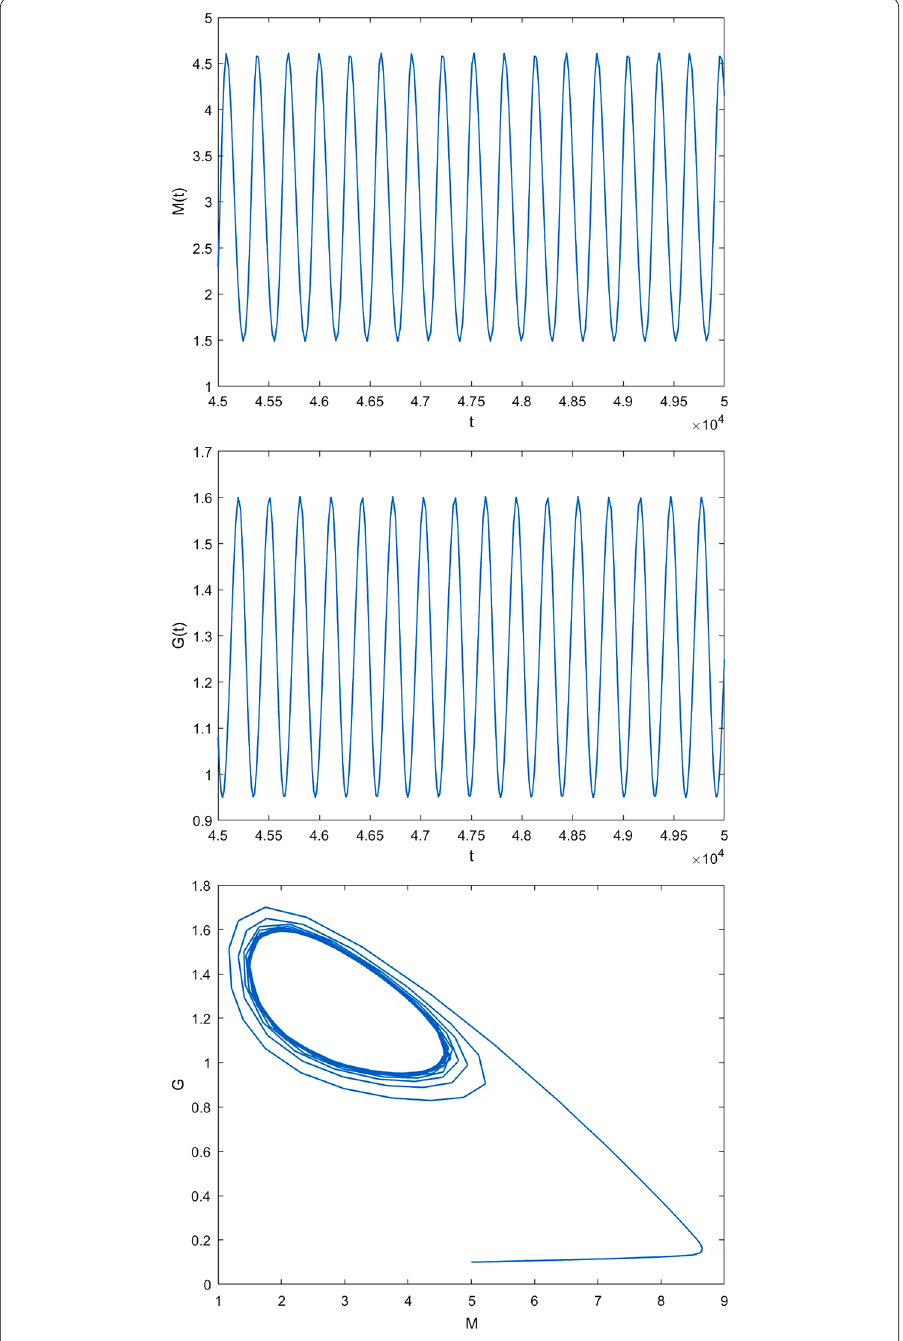
Figure 6 A computer simulation of the system (2.1)–(2.2) with a 1 = 0.1450, a 2 = 0.6937, b 1 = 0.0596, b 2 = 0.0206, α 1 = 0.16385, k 1 = 15.64, k 2 = 12.4113, τ = 35 > τ 0 = 22.5131, where M (0) = 5 and G (0) = 0.1, for which all conditions in Theorem 4 are satisfied. The solution trajectory exhibits periodic behavior as theoretically predicted